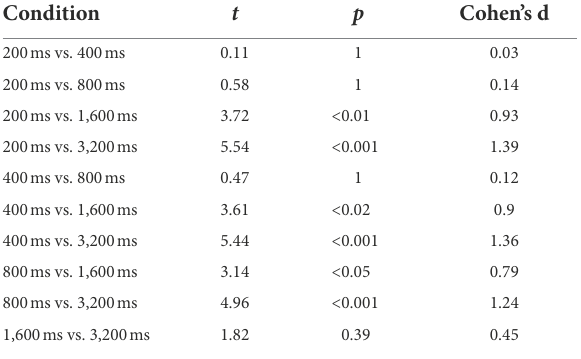
TABLE 2 Summary of t -tests for the WFs in the temporal estimation task.